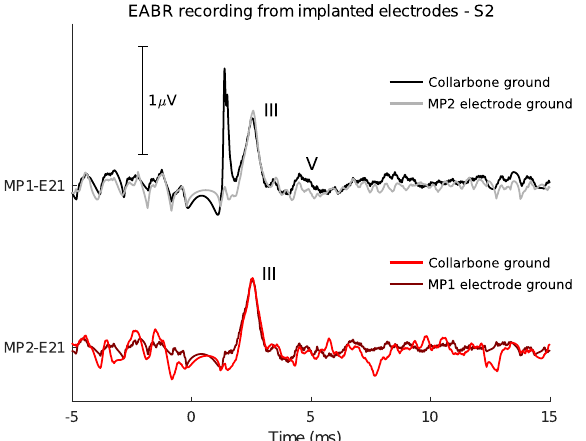
Figure 5. Comparison between EABRs using an external ground electrode (collarbone) or an implanted ground electrode (MPx). Stimulation settings were identical to those used for other EABRs obtained at